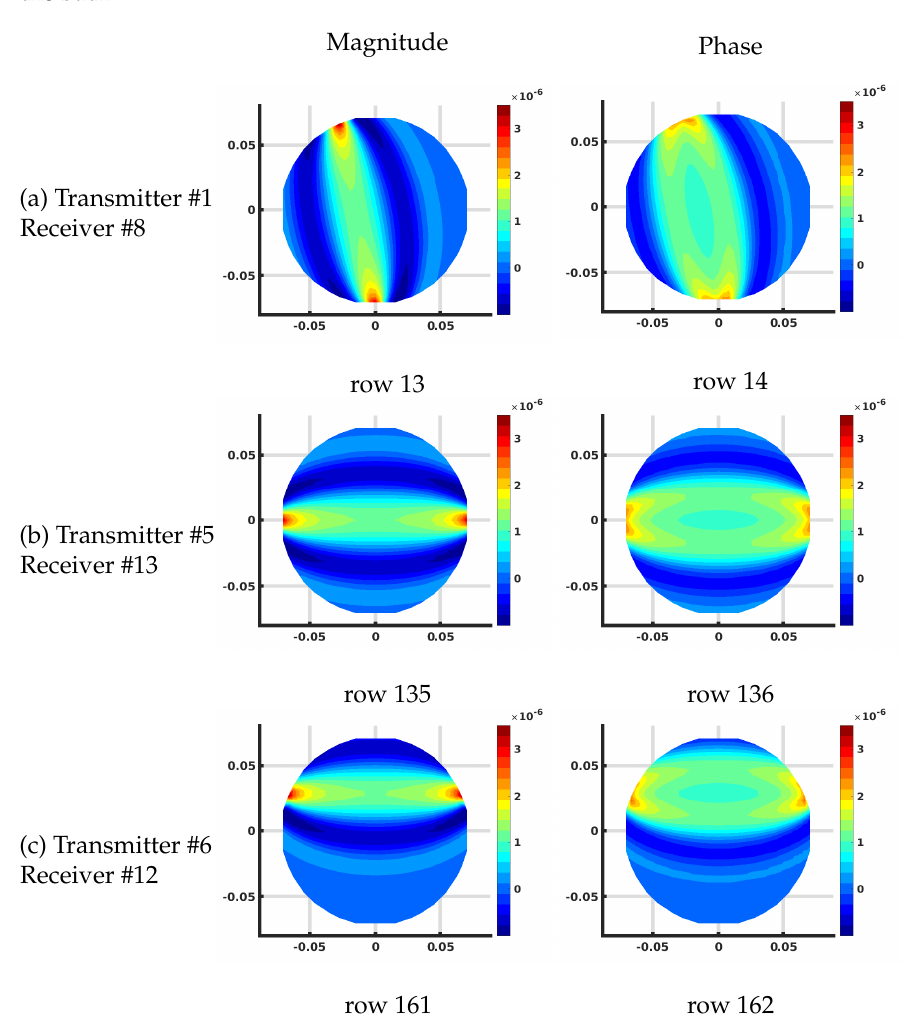
Figure 7. Plots of the effective log magnitude ( left ) and phase ( right ) distributions for various rows of Jacobian matrix (m 2 ), corresponding to multiple transmitter/receiver pairs, for the discrete dipole approximation (DDA)-based algorithm. The distributions are presented on the DDA grid. Note that the plotting algorithm smoothed the imaging zone shape with triangles around the sharp edges of the reconstruction